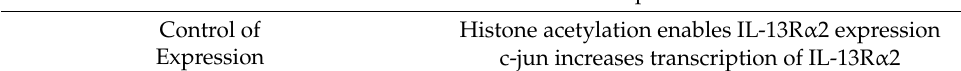
Table 1. The function of IL-13R α 2 and the control of the expression in pancreatic cancer. Function of IL-13R α 2